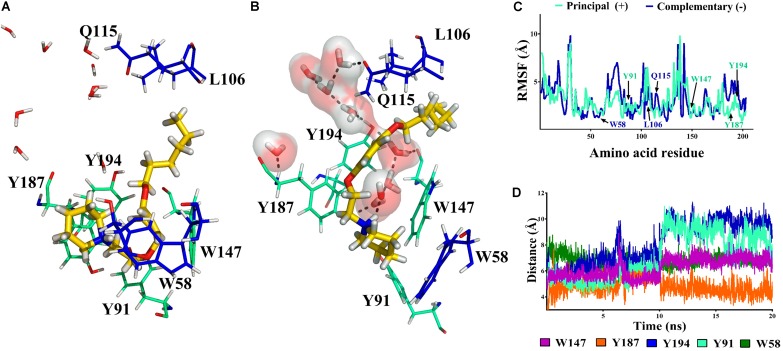
Compound 11a (in yellow) in the binding cavity of the α7 nAChR. (A,B) Shows the α7/11a complex at 0 and 20 ns, respectively. All amino acids from the principal (+)- and complementary (-)- chains at 5 Å are displayed (cyan and blue respectively). (C) The RMSF values of the amino acids in the principal (+)- and complementary (-)-chains show that the position of alpha carbon (Cα) of the residues involved at the binding site persist during the simulation (W147, W58, and Y187). (D) The distance from the nitrogen atom (NC) of 11a to the closer amino acids is shown.